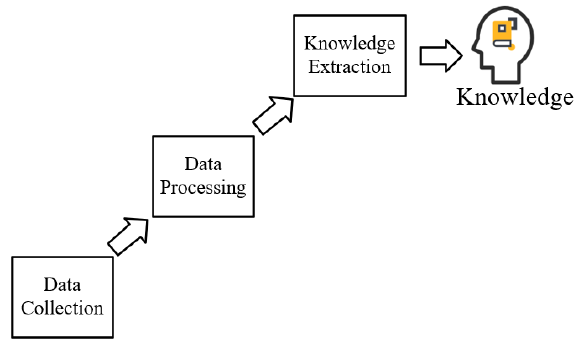
Figure 1. Overall process of the proposed method.